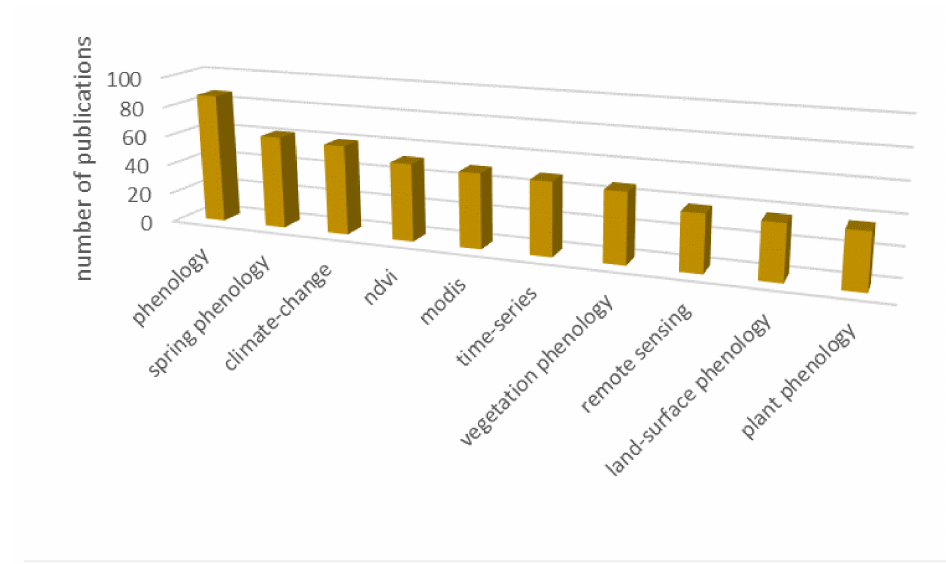
Figure 4. Most frequent keywords used in the analyzed